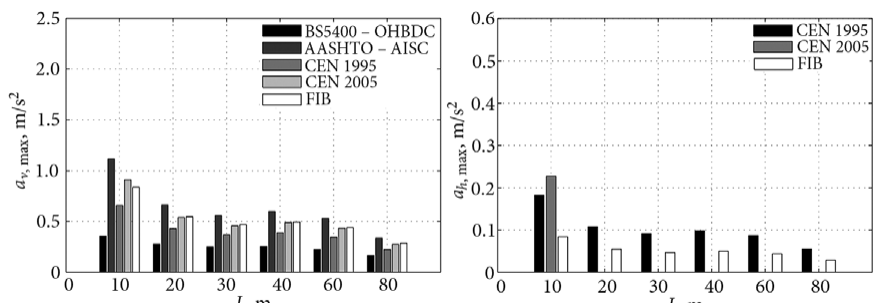
Fig. 11. Vertical and lateral accelerations induced by a single resonant walker